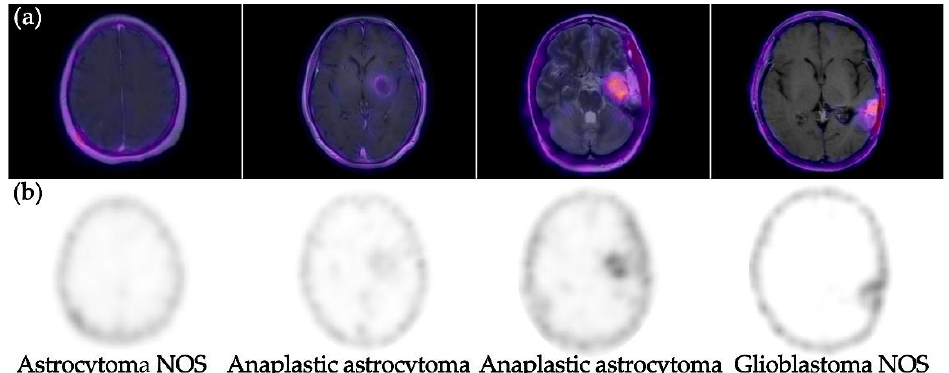
Figure 1. ( a ) [ 99m Tc]Tc-iFAP SPECT coregistered to MR images (SPECT/MRI) and ( b ) [ 99m Tc]Tc-iFAP SPECT. Note the adequate visualization of [ 99m Tc]Tc-iFAP uptake in high-grade gliomas (WHO III-IV)-treatment-naive and recurrent (R). However, low-grade glioma (WHO II) did not show uptake. For all cancer cases, a total of 111 lesions were evaluated, which were classified as primary tumors (PT)( n = 26), lymph node metastases (LNm) ( n = 61), and distant metastases (Dm) ( n = 24) (Table 3). Table 3. Number of lesions detected with [ 99m Tc]Tc-iFAP and [ 18 F]FDG in all patients except gliomas. Primary Tumor Lymph Node Metastases Distant Metastases